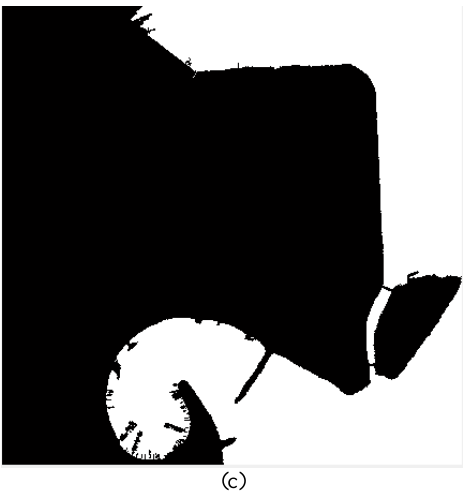
Figure 5. base image filtered. a) first stage, b) second stage and c) third stage.